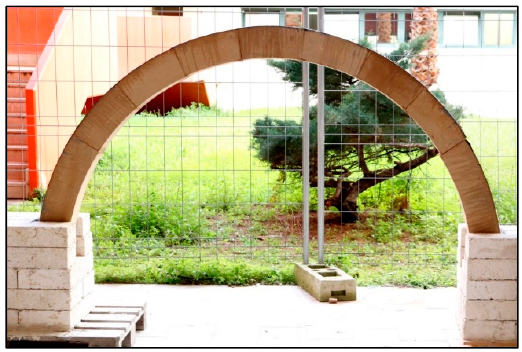
Figure 12. Placing of the HLA on the buttresses.